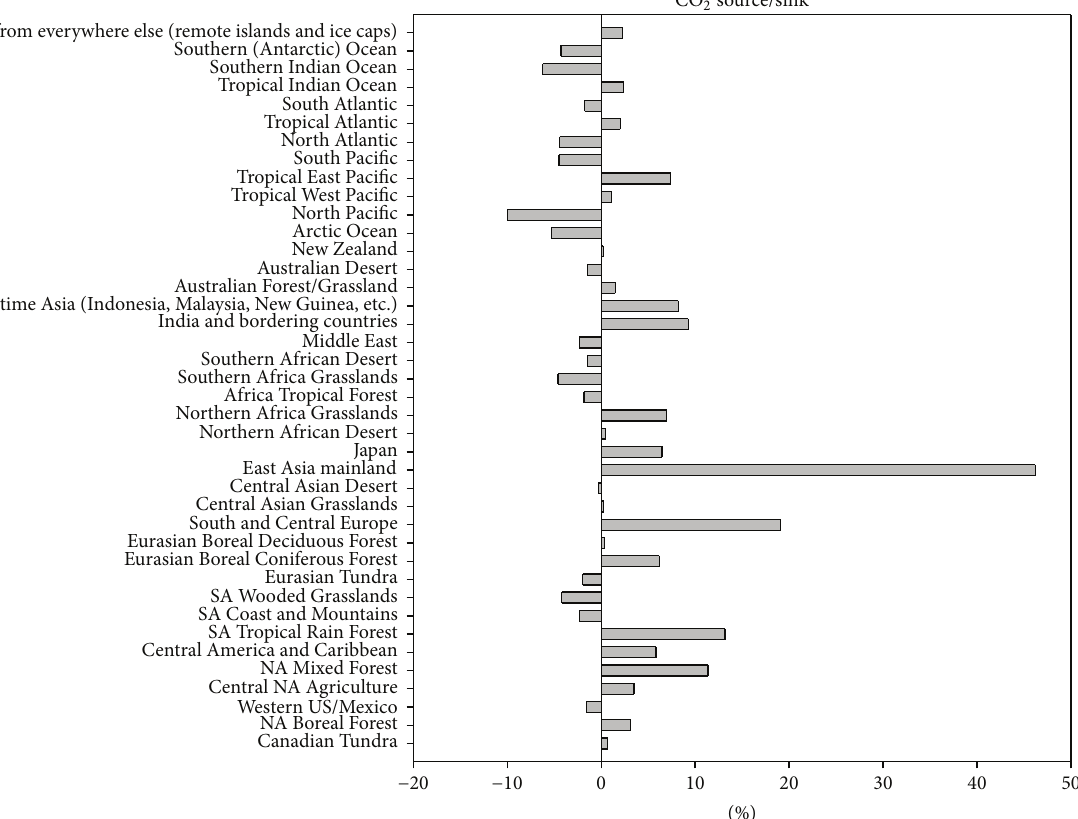
Figure 10: The contribution of sources and sinks to atmospheric CO 2 concentration of the East Asian regions simulated by GEOS-Chem tagged